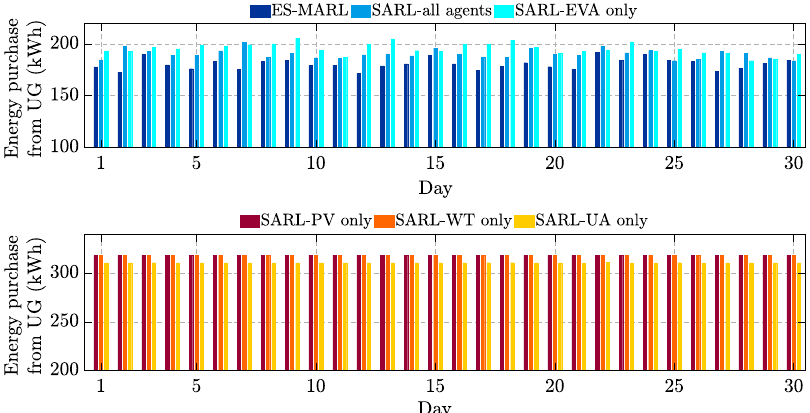
Figure 9. Agents’ average profits different RL configurations and different microgrid configurations.